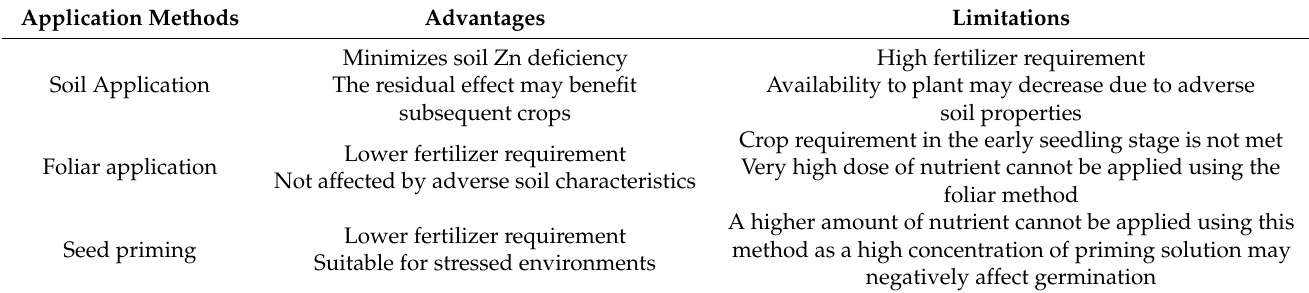
Table 2. Different Zn application methods, their advantages and